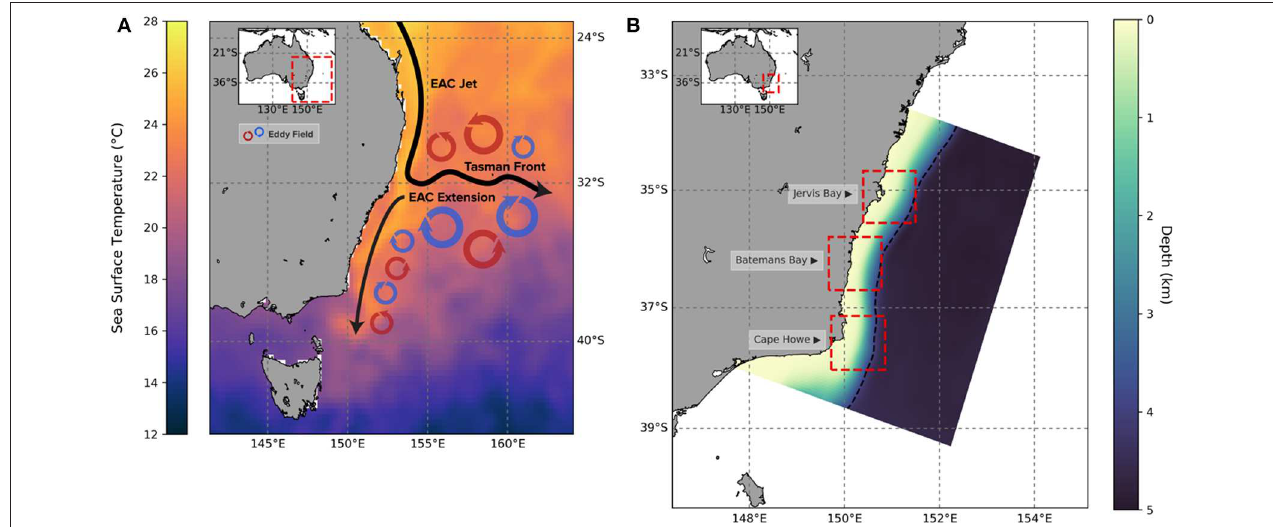
FIGURE 1 | (A) A simplified schematic of the East Australian Current (EAC) showing the primary features and eddy fields. The schema is overlaid over mean SST for the 10th of December, 2000—provided by NOAA (https://psl.noaa.gov/data/gridded/data.noaa.oisst.v2.highres.html) (Reynolds et al., 2007) and; (B) Map of the study region in southeastern Australia showing the extent of the hydrodynamic data-subset used in the analysis, with bathymetry overlaid. The three marine ecosystem study sites are shown as red boxes. Only the regions within the boxes between the coast and the 4,000 m bathymetric contour line (black dotted line) were